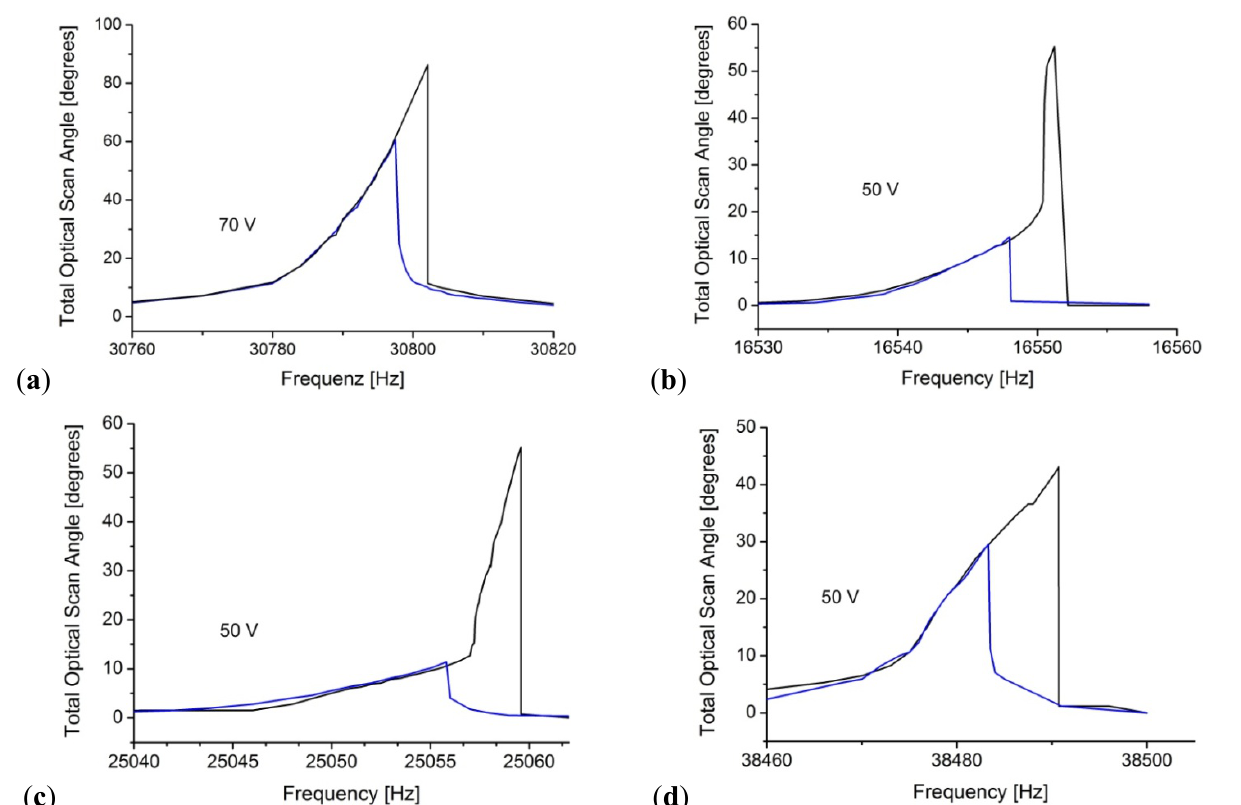
Figure 12. Frequency response. Blue curves represent downward sweep, black